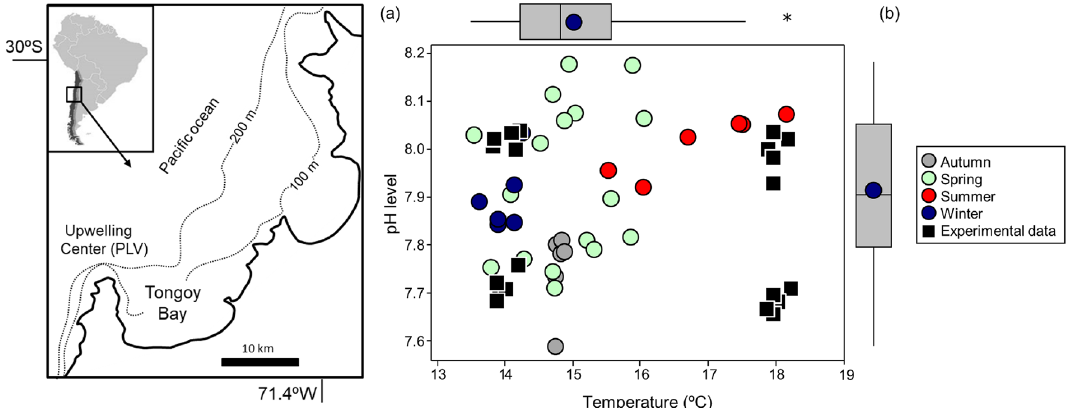
Figure 1. Environmental context of the study. (a) Tongoy Bay and Pt. Lengua de Vaca (PLV), the nearby upwelling centre influencing fluctuations in temperature and pH inside the bay where scallops Argopecten purpuratus are farmed; ( b ) Variability in pH and temperature for the combination of experimental treatments (solid black squares); overlapped with the natural variability in temperature/pH (solid circles) recorded seasonally inside Tongoy Bay from dec-2014 to May-2016. A boxplot (median, mean and range) for all records of temperature and pH are shown at the top and right side of the graph, respectively.